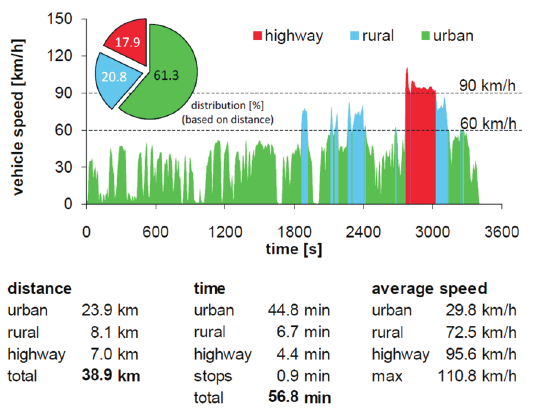
Fig. 8. AFHB Road-Test Route. PEMS 2, Seat Leon 1.4 TSI Euro 5b The distinction between the driving modes: urban, rural, highway is performed by the evaluating program according